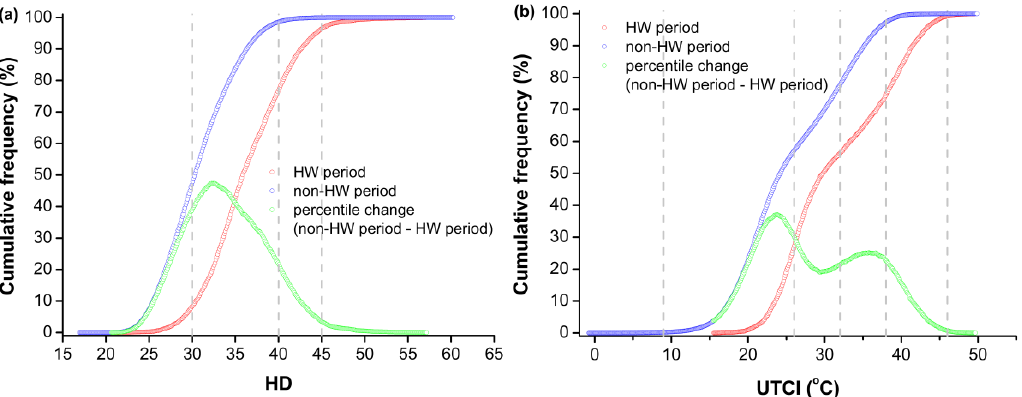
Figure 4. Cumulative frequency of ( a ) HD; ( b ) UTCI over the HW period and the non-HW period. The period of HWs refers exclusively to the 46 events of the 1960 – 2017 period, while the non-HW period refers to the reference period (1971 – 2000) without the detected HWs of that period. The percentile change between the two considered periods is also illustrated. The vertical dashed lines indicate the thresholds of each index as presented in Table 1 and Table 2.